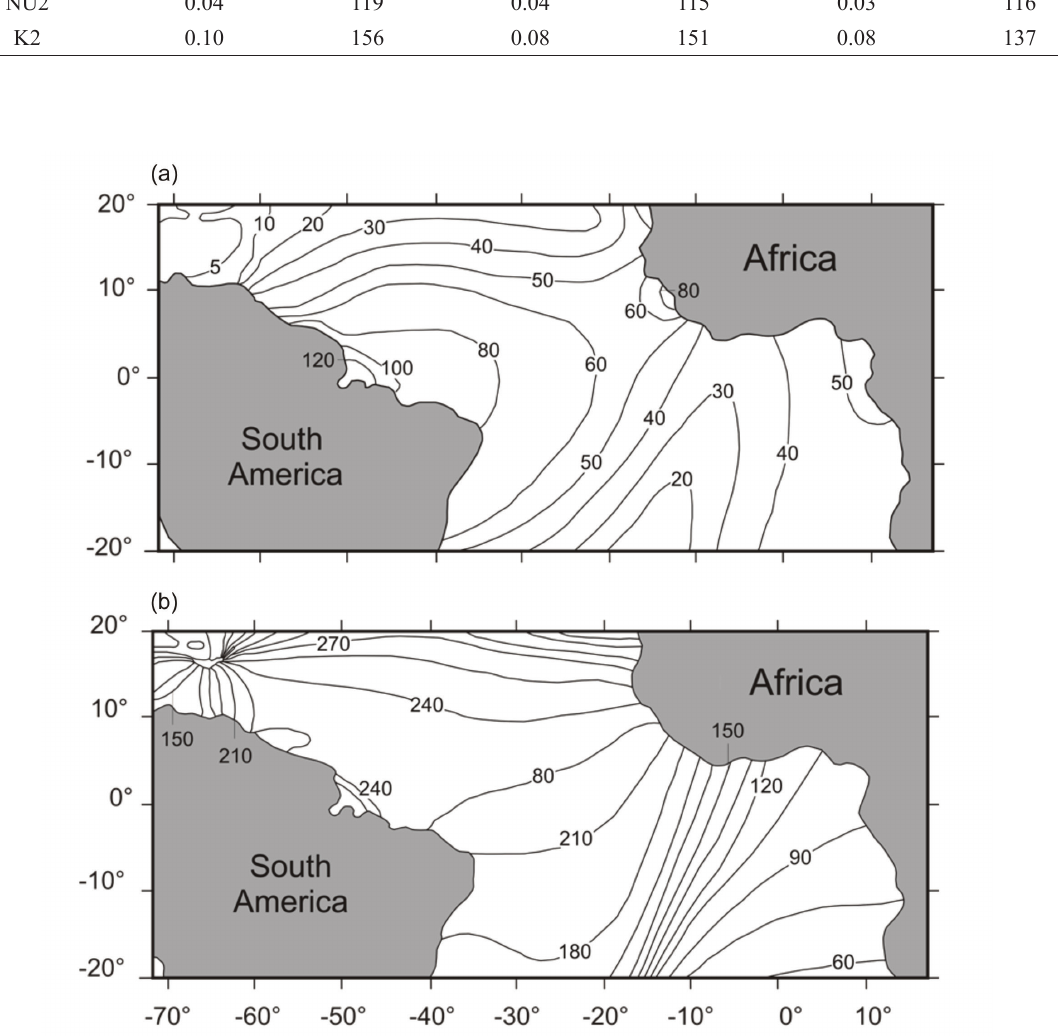
constituent in the tropical Atlantic Ocean. (a) Amplitude in Figure 2 - Co-Tidal chart for the M 2 centimeters and (b) phase in degrees to Greenwich. Adapted from Beardsley et al.